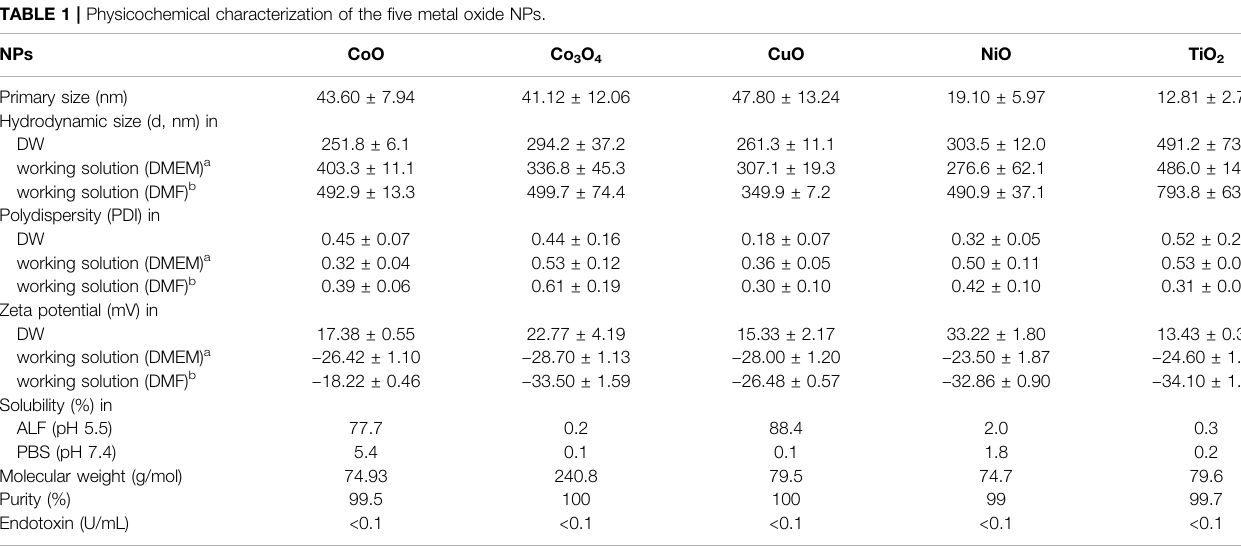
TABLE 1 | Physicochemical characterization of the fi ve metal oxide NPs.